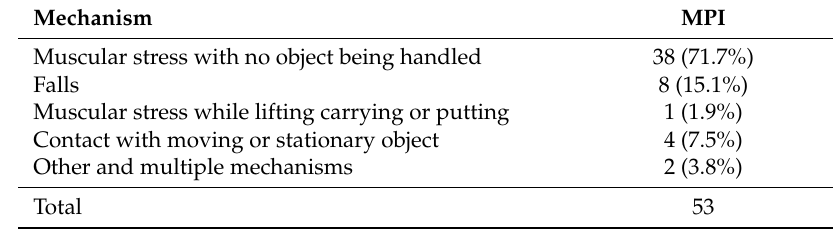
Table 5. Knee injuries suffered during physical training. Number of injuries (% of